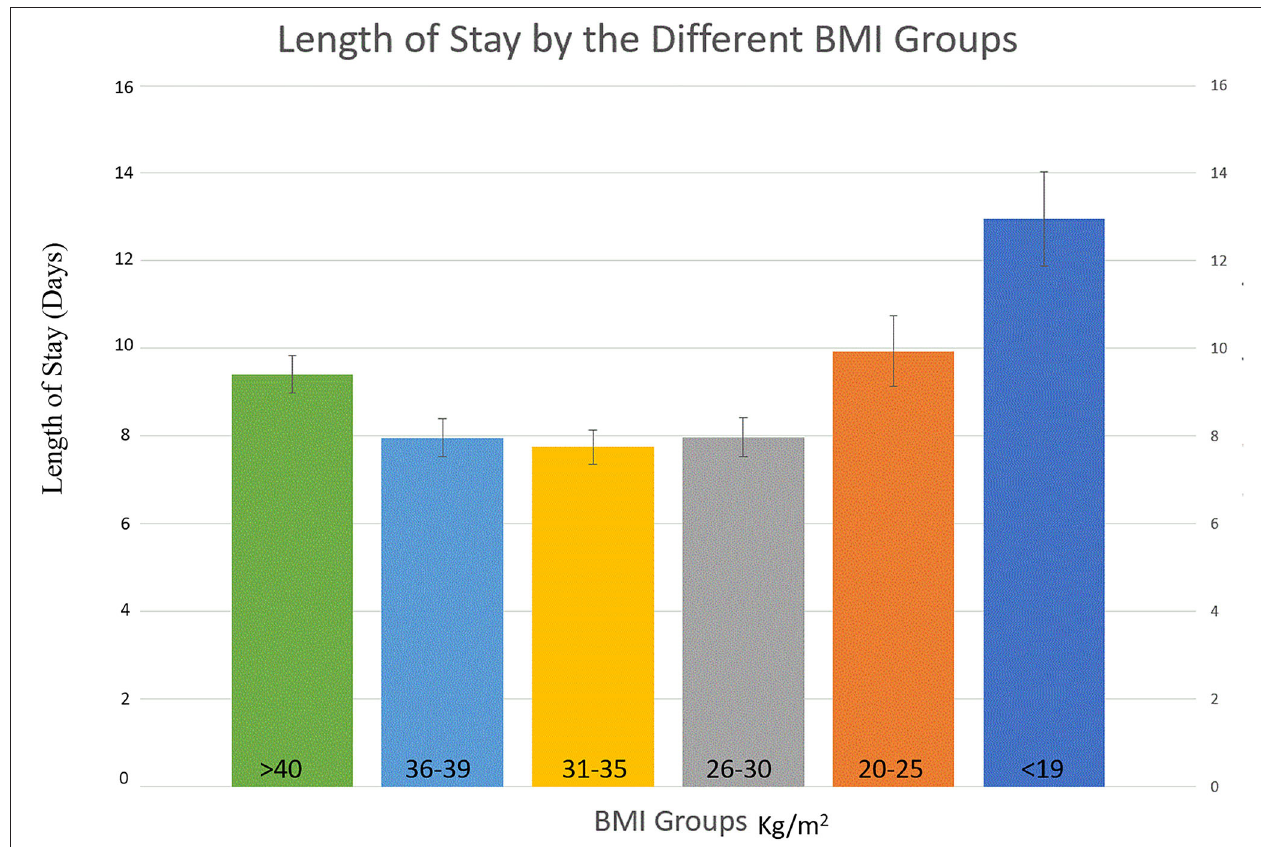
FIGURE 1 | Length of Stay per BMI